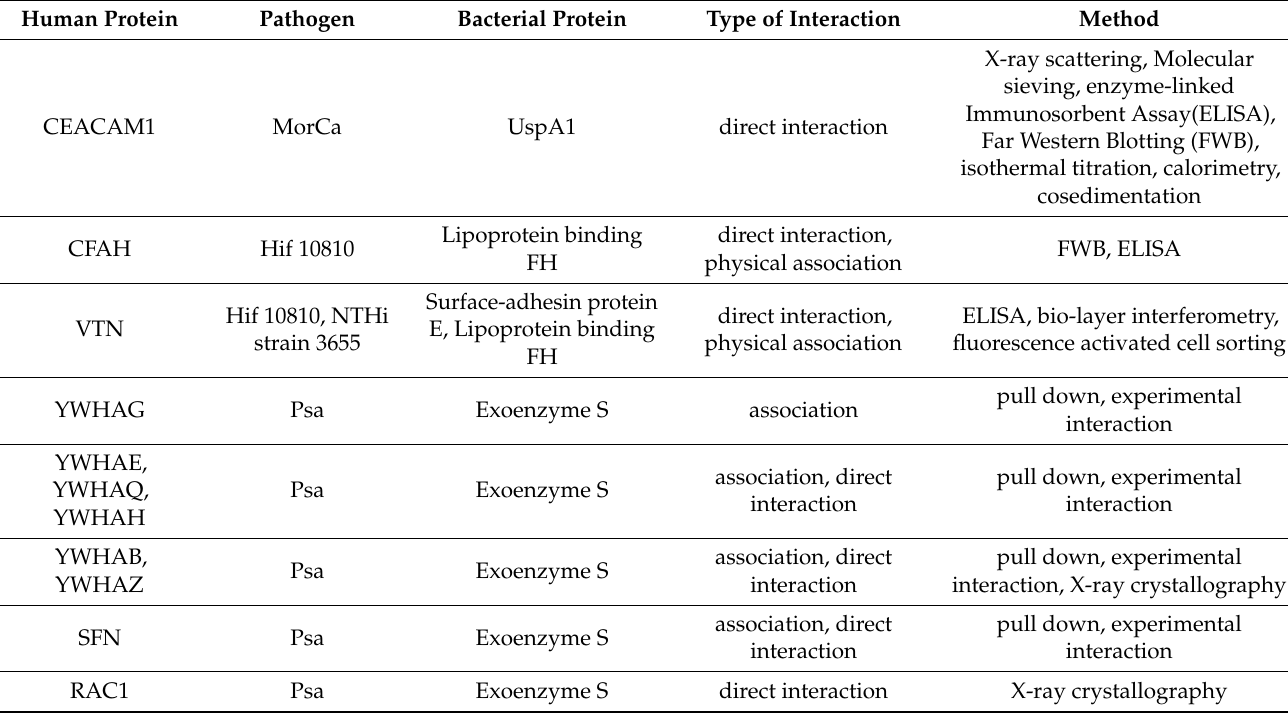
Table 1. The Human-MorCa/Psa/Hi interactome as retrieved by the Host Pathogen Interaction Database version 3.0 (HPIDB